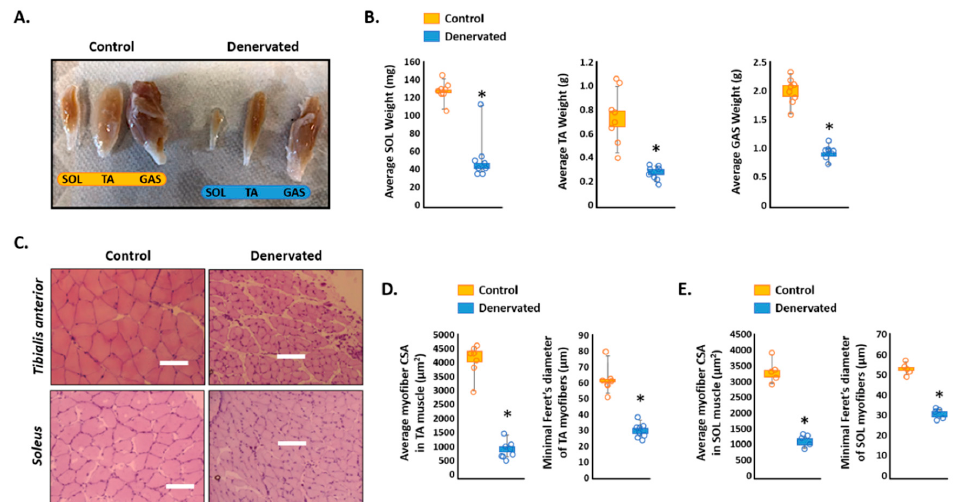
Figure 1. Effect of sciatic nerve transection on skeletal muscle maintenance in Sprague–Dawley (SD) rats. Eight male rats had their sciatic nerves ligated on one side of the body. After 14 days, the SD rats were sacrificed and perfused. ( A ) Visual depiction of the control and denervated leg muscles, Scale bar = 100 µ m. ( B ) Average wet weight of soleus (SOL), tibialis anterior (TA) and gastrocnemius (GAS). ( C ) Hematoxylin and Eosin (H&E) stain of the TA and SOL of control and denervated muscle. Scale = 100 µ m. ( D , E ) The average cross-sectional area (CSA) and minimal Feret (cid:48) s diameter of the control and denervated TA and SOL muscles. * p < 0.05, values significantly different from the control mice by a paired two-tailed t